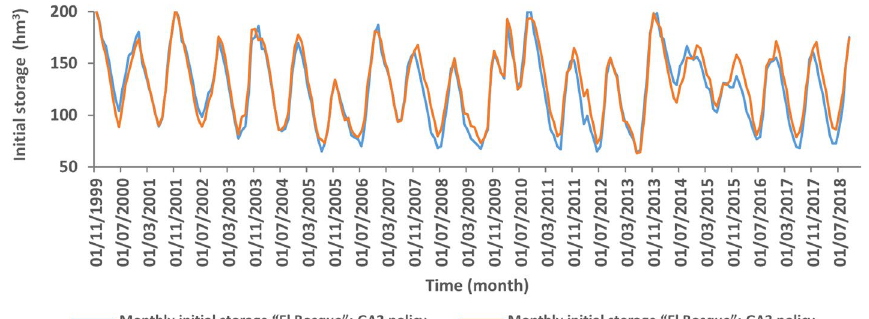
Fig. 18 The monthly initial storage values of the Valle de Bravo reservoir with GA2 and GA3 policy